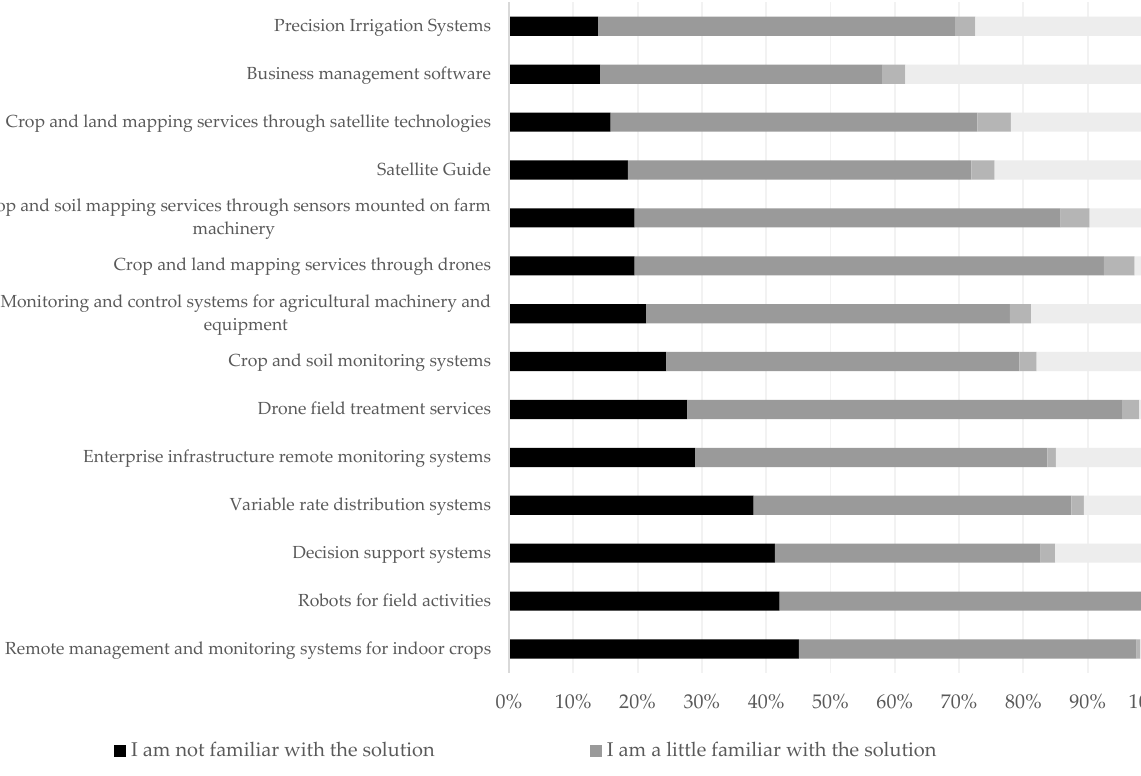
Figure 3. Agri 4.0 solutions awareness level.